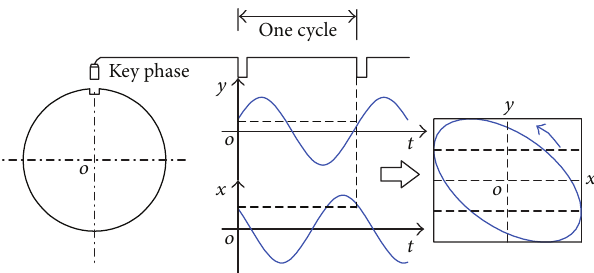
Figure 6: Diagram of synchronous integrated period sampling.